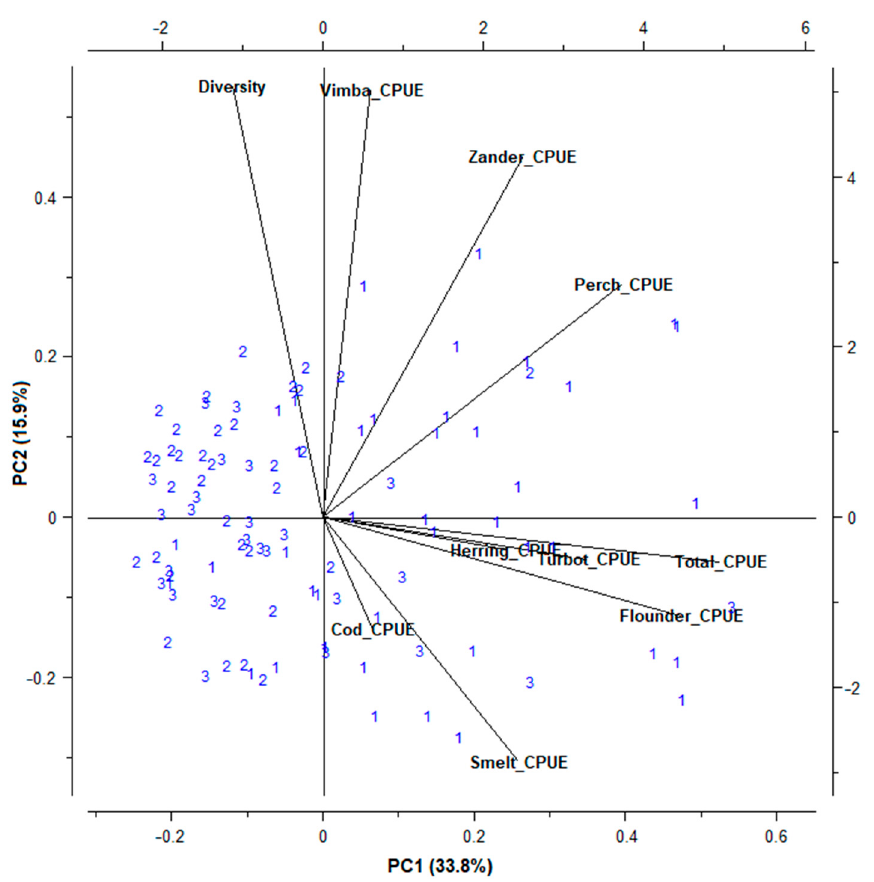
Figure 4. PCA correlation biplot for the diversity and square-root transformed total and main species CPUE of coastal fish assemblages under upwelling conditions. Blue number of samples refers to the fish assemblages from different sampling locations: 1 − Klaipeda, 2 − Karkle, 3 − Sventoji. The first two axes explained 50% of the data variability (34% and 16% respectively).